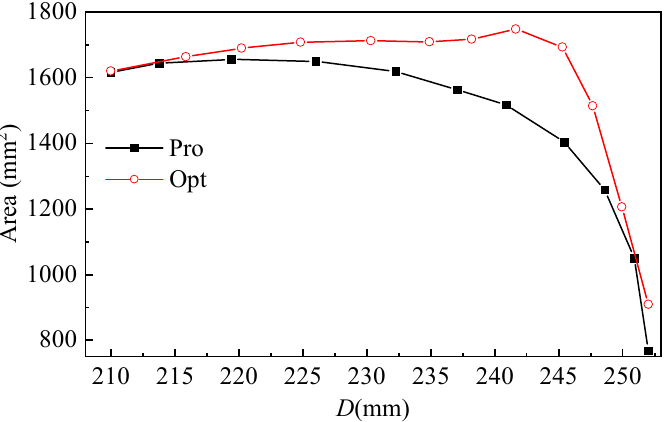
Figure 18. Change of cross-sectional area with diameter D .